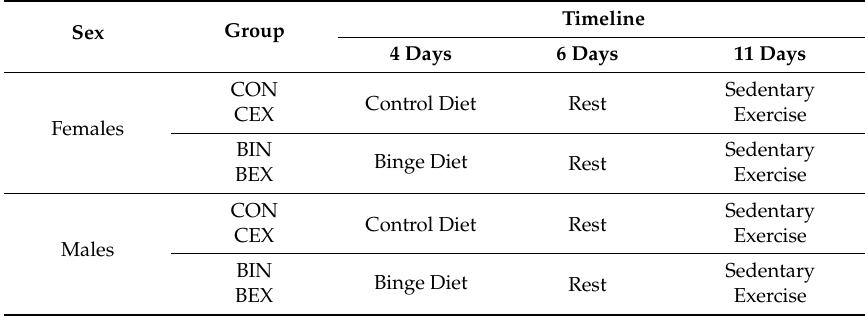
Table 1. Experimental design.